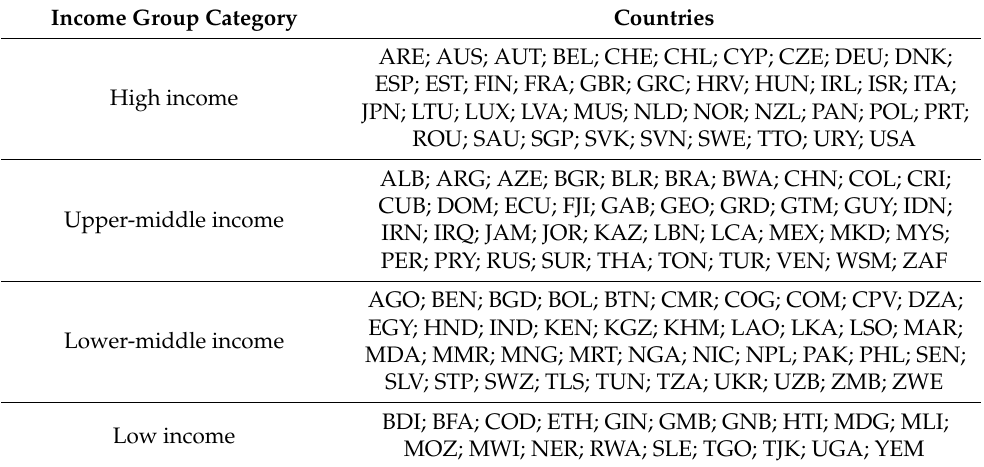
Table A1. Countries included in each income group (according to the classification standard provided by the World